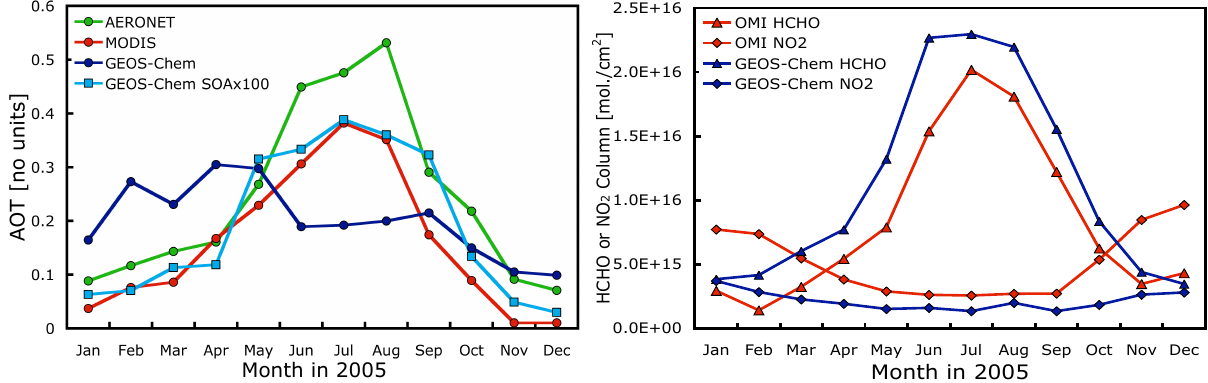
Fig. 8. Seasonal variations in aerosols and trace gases for the grid box centered at 33.5 ◦ N, 85.5 ◦ W. Left panel shows the AOT from satellite (MODIS) and ground-based (AERONET) remote sensing, as well as model simulations with GEOS-Chem. Also, the GEOS-Chem AOT for the SOA component multiplied with a factor of 100 is shown. The right panel shows the HCHO and NO 2 troposheric columns from satellite observations (OMI) and GEOS-Chem